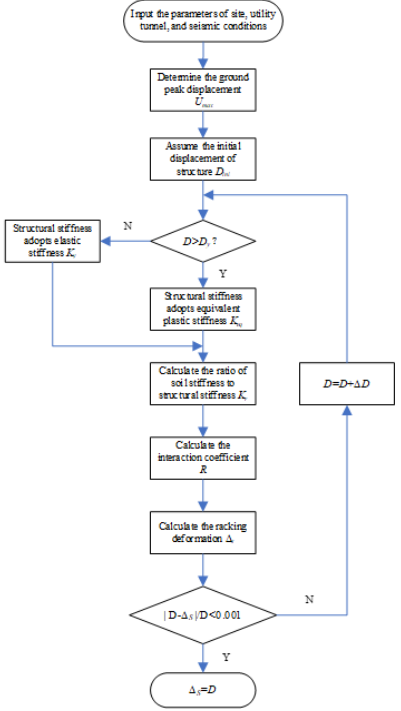
Figure 14. Idealized elastic rigid-plastic curve.